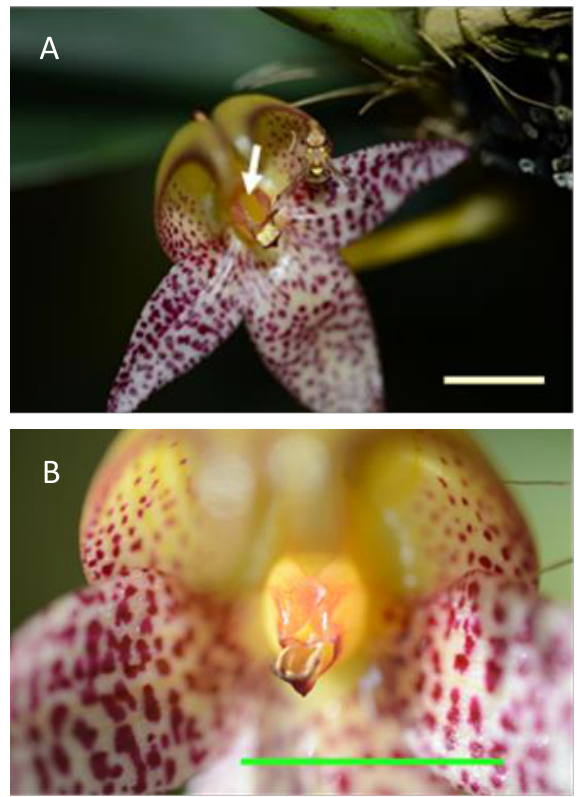
F IGURE 4. Natural pollination of Bulbophyllum praetervisum by a Dacini fruit fly. (A) Freshly deposited pollinia (arrow) on the stigma by a fruit fly. (B) Column wall teeth folded to cover the pollinia, ca 4.5 h after deposition by the fly. Bar: 1